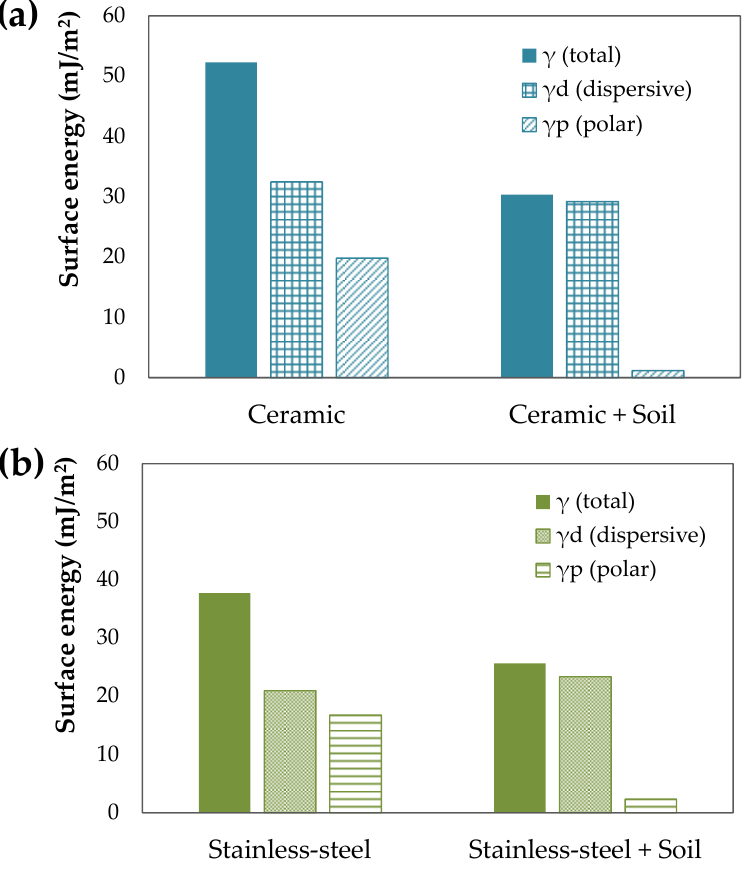
Figure 2. Results of total, dispersive, and polar surface energies on the clean and soiled surfaces: ( a ) ceramic and ( b ) stainless steel.